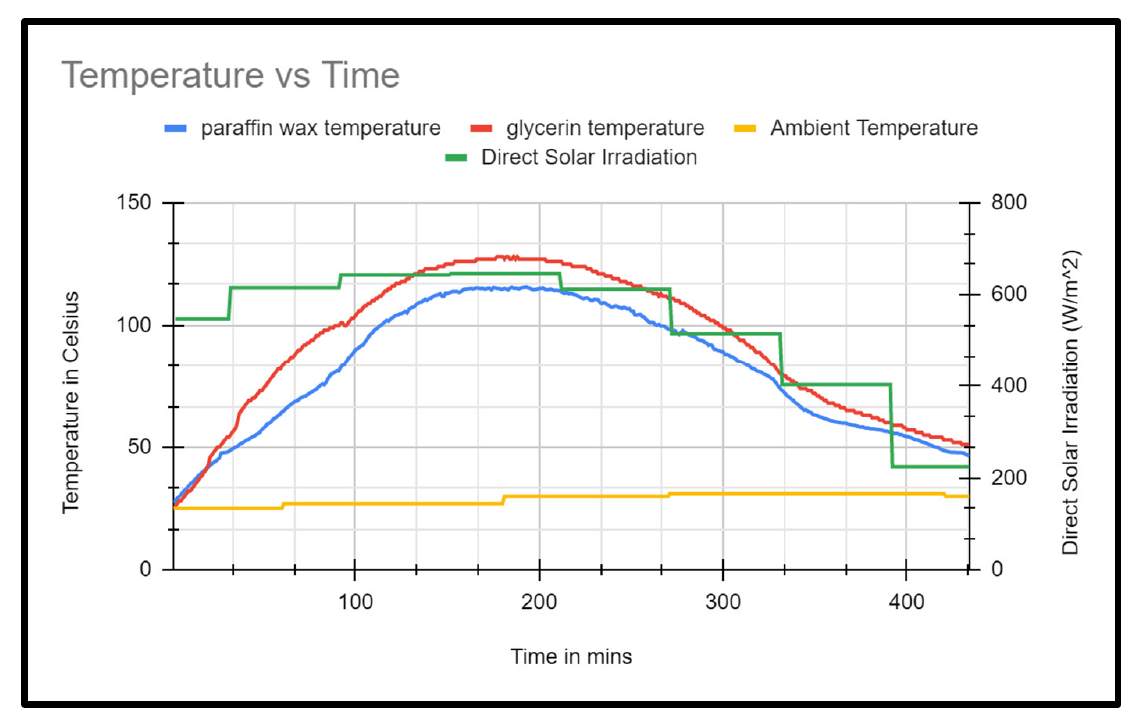
Figure 9. Temperature and irradiation values from day 3 using glycerine as test load and paraffin wax as heat storage material.